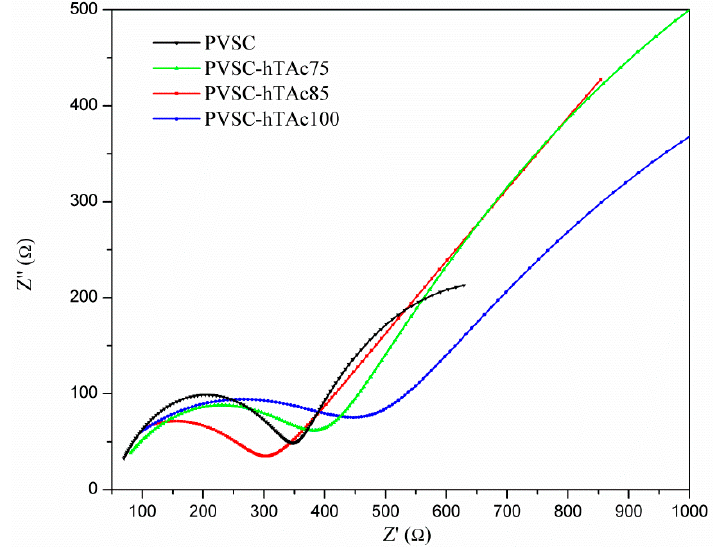
Figure 5. Nyquist plots of the electrochemical impedance spectra of PVSCs incorporating various h-TAc amounts in the active layer. Table 1. Photovoltaic characteristics of PVSCs incorporating various h-TAc amounts in the active layer.